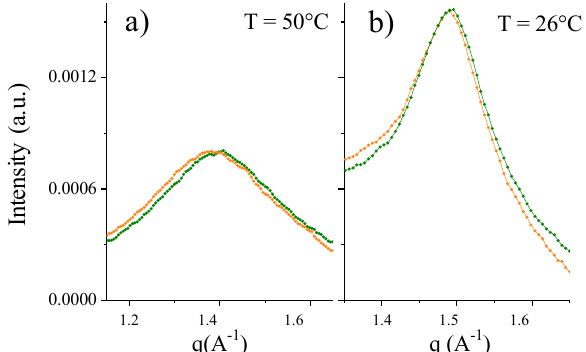
Figure 5. Raft-mime membranes upon interaction with A β monomers. Wide angle x-ray scattering (WAXS) of raft-mime asymmetric DPPC:Chol:GM1 = 10:1.25:0.5 bilayer before (olive curves) and after (orange curves) 1 h incubation of A β (1–42) monomers at (0.2% mole fraction to the lipid). ( a ) T = 50 °C, in the fluid phase. ( b ) T = 26 °C, in the gel phase. In both phases, the local-arrangement-peaks shifted to lower q-values: from 1.396 Å − 1 to 1.380 Å − 1 at T = 50 °C and from 1.493 Å − 1 to 1.490 Å − 1 at T = 26 °C.